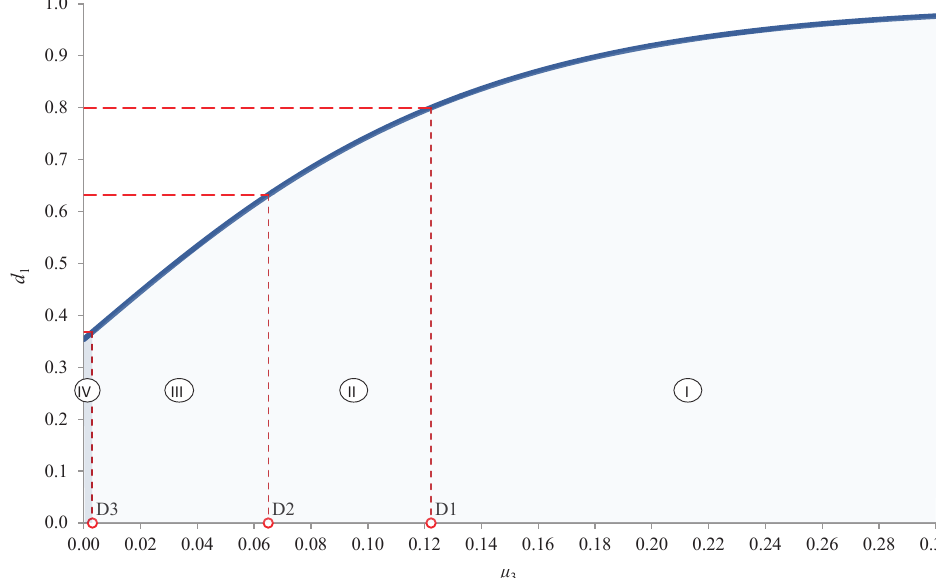
Figure 3 Graphic interpretation of Harrington’s individual desirability function given condition